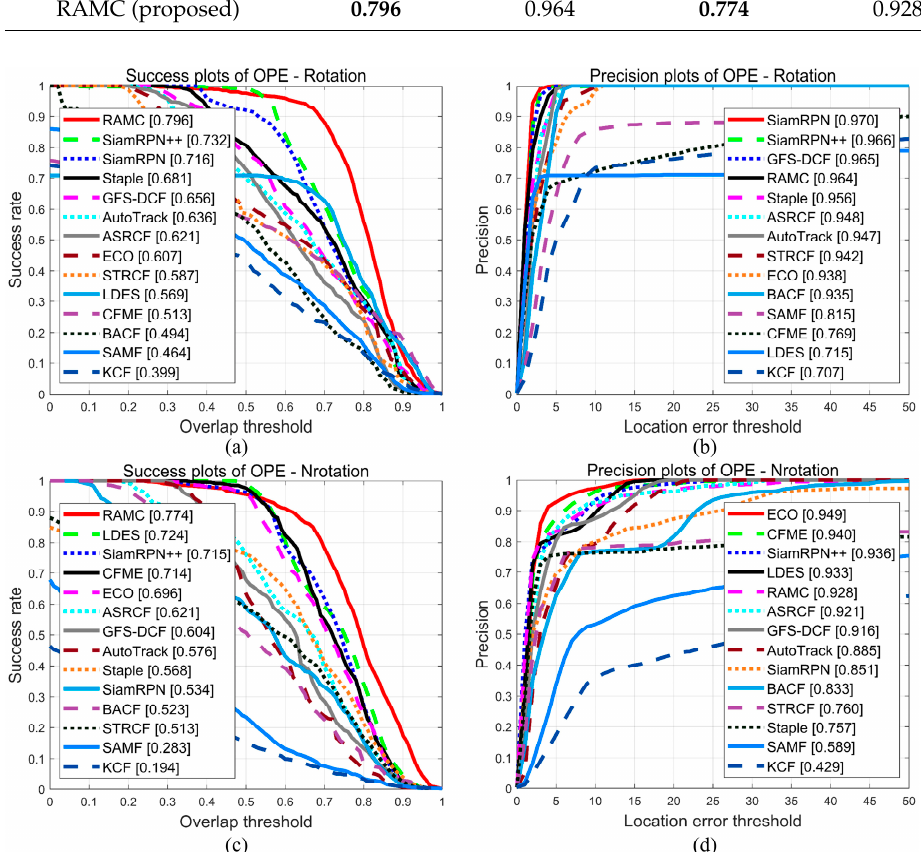
Figure 10. Success and precision plots of all algorithms on the Rotation and Nrotation datasets. ( a ) and ( b ) indicate the success plot and precision plot under the Rotation datasets, respectively. ( c ) and ( d ) indicate the success plot and precision plot under the Nrotation datasets, respectively.